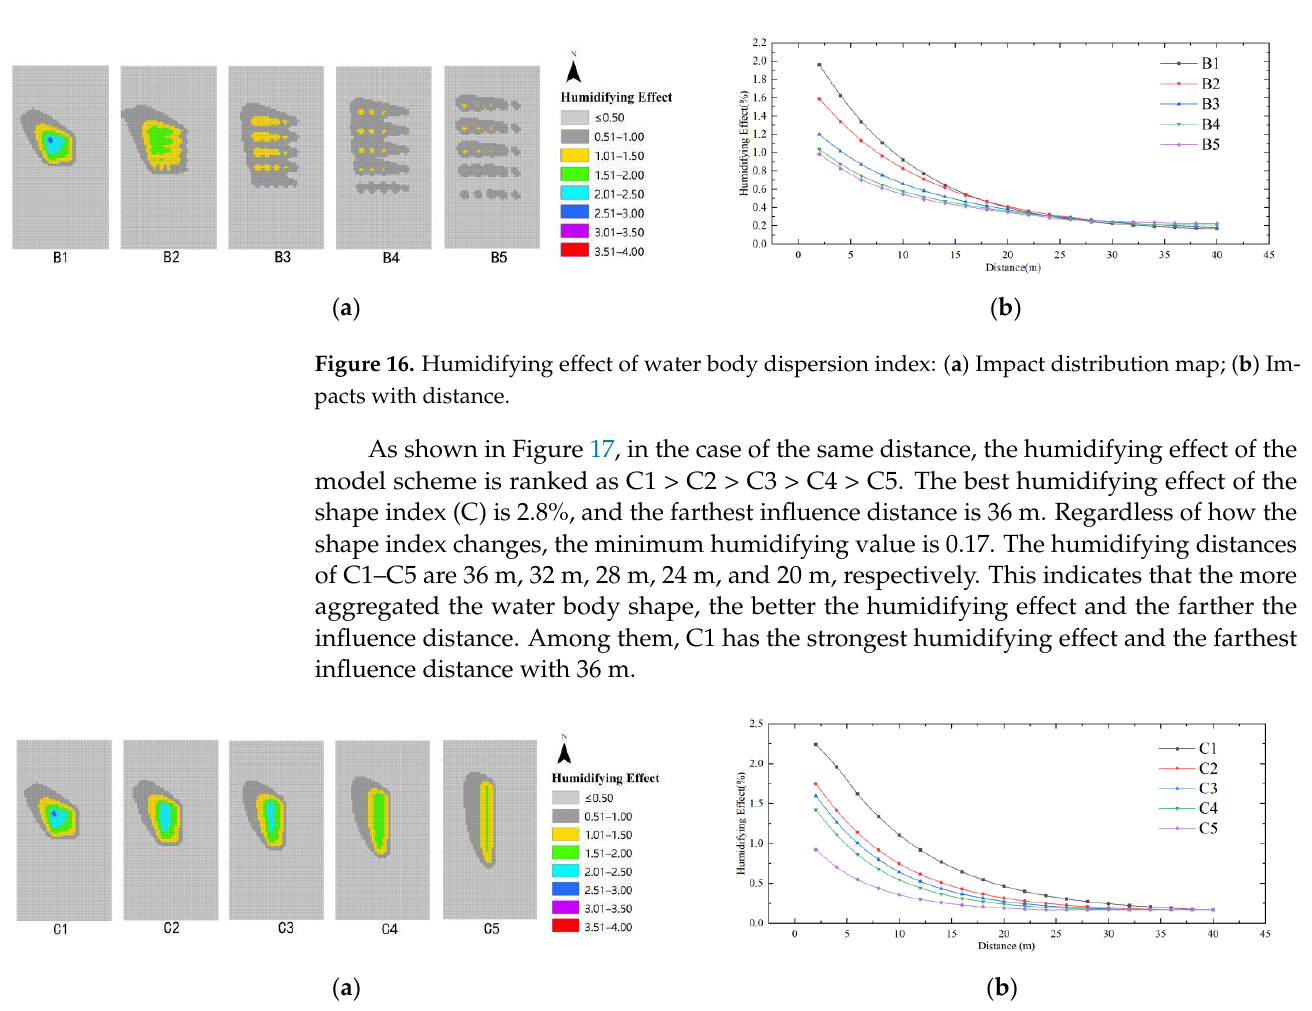
Figure 15. Humidifying effect of water body area index: ( a ) Impact distribution map; ( b ) Impacts with distance.